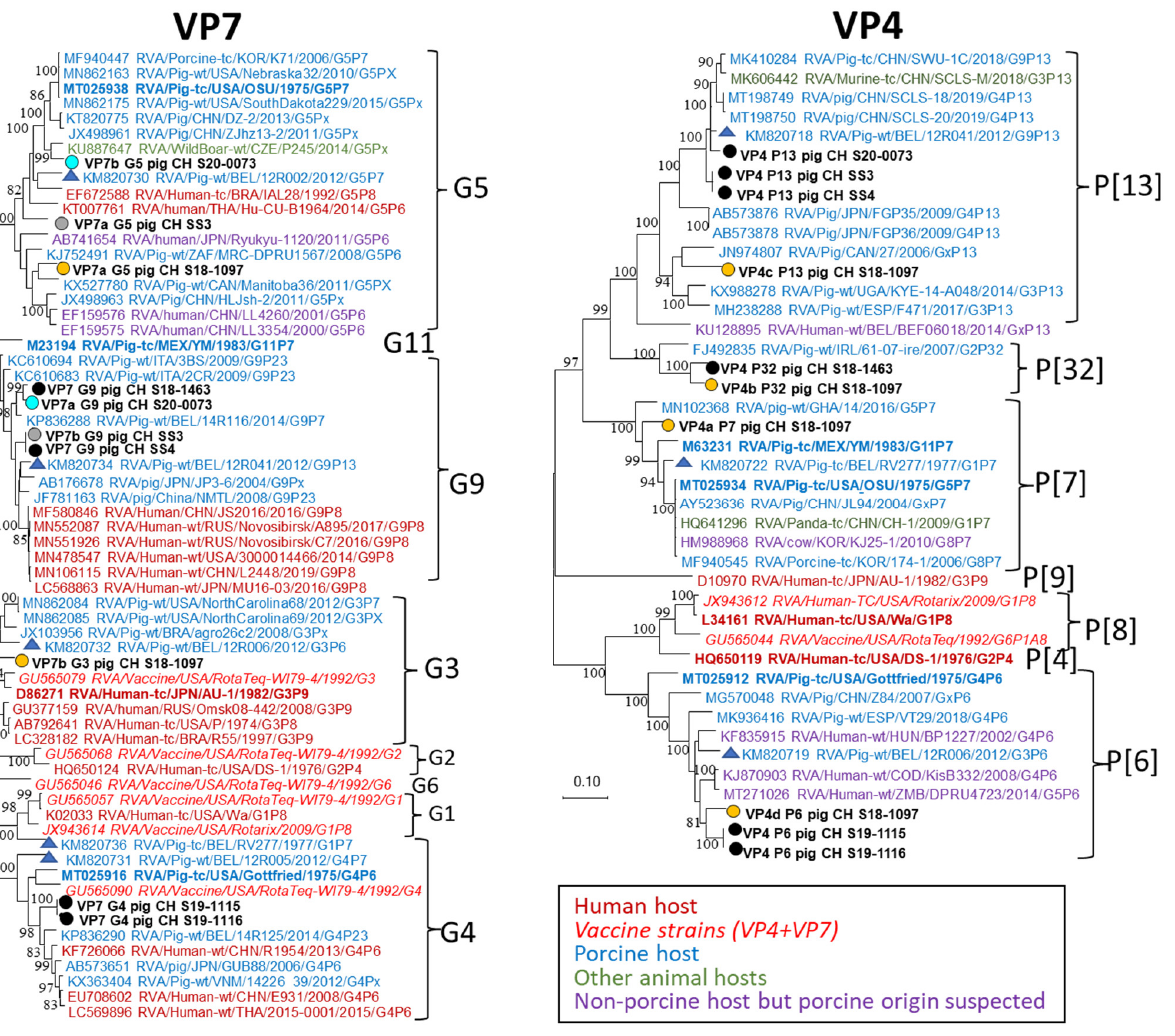
Figure 5. Maximum likelihood phylogenetic trees of the CDS of VP7 and VP4 sequences. RVA strains from this study are highlighted with circles, and names are written in bold black letters. Circle fill-colors gray, blue, and yellow indicate the common origin of co-infecting sequences. Letters after the protein ID of the Swiss strains (e.g., VP7a and VP7b) indicate multiple sequences for the CDS of this segment. Names of human reference strains are written in dark red, vaccine strains in light red and italic, porcine reference strains in blue, and strains from other animals in green. Viral sequences gained from non-porcine hosts but suspected to originate from pigs through interspecies transmission or following reassortment are marked in purple. The porcine lab strains included in Table 1 are highlighted in bold, and the Belgian reference strains from Table 1 are highlighted with blue triangles.